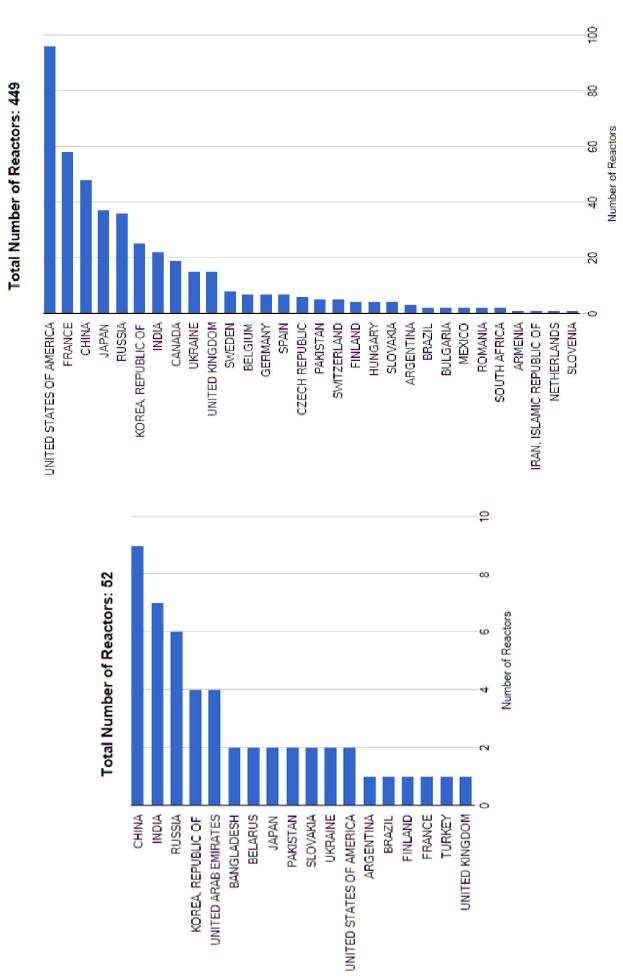
Fig. 7. – Number of operational and long-term shutdown reactors by type (top, as of October 2019). Reactors under construction by type (bottom, as of October 2019) [6] (Copyright c (cid:2) 2019 International Atomic Energy Agency